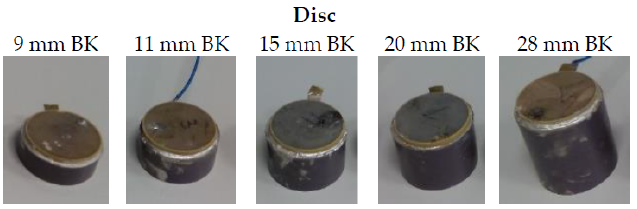
Figure 16. Backing layers attached to the disc ceramics.